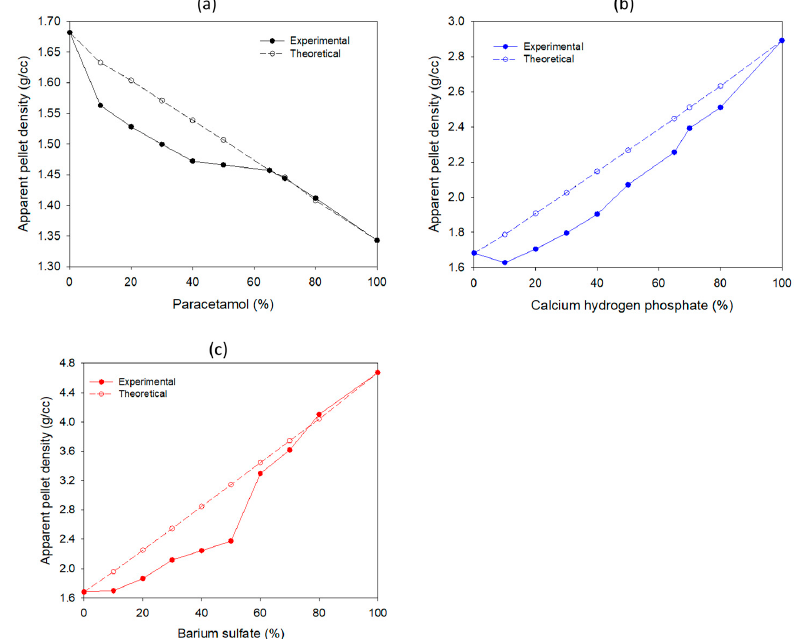
Figure 2. Change of the “apparent” pellet density by the addition of density modifiers to microcrystalline cellulose (standard deviation of experimental pellet density measurements was ≤ 0.001). ( a ) Paracetamol; ( b ) calcium hydrogen phosphate; ( c ) barium sulfate.